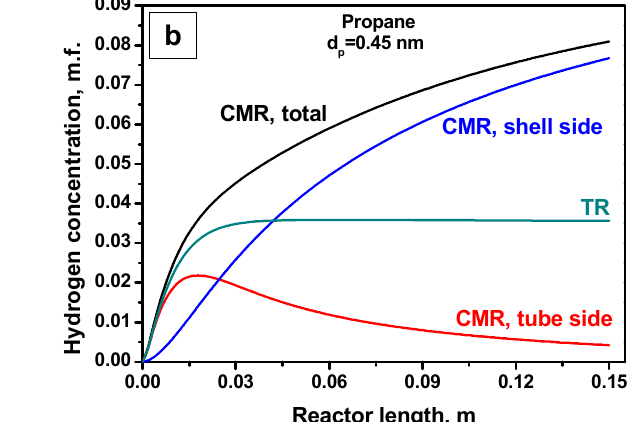
Figure 3. Alkane conversion at the reactor outlet depending on the membrane pore diameter.